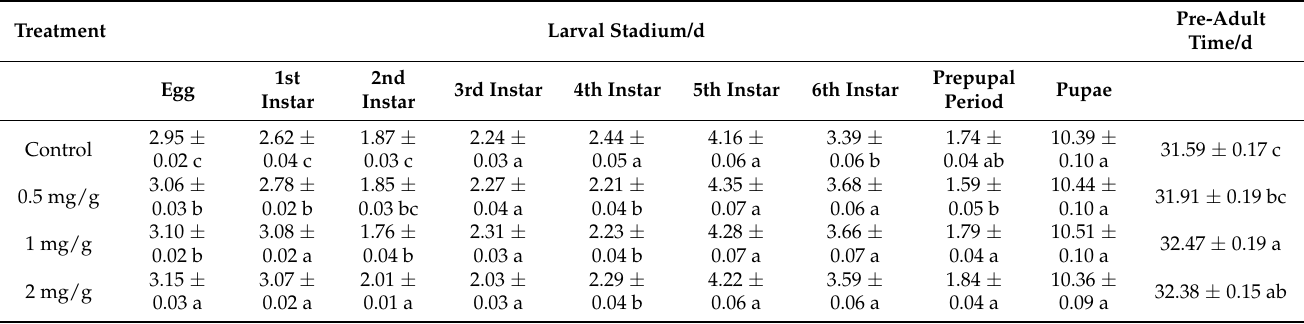
Table 3. Developmental stages of Spodoptera frugiperda fed with different GO concentrations.